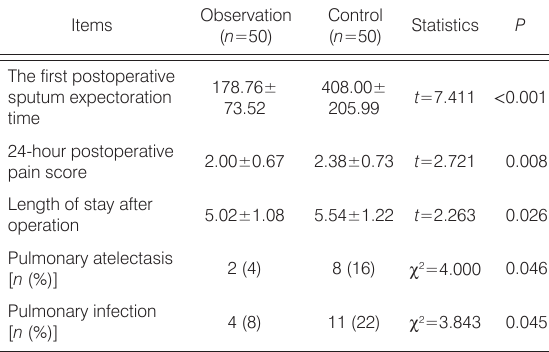
Table 2. Comparison of two groups after the first expectoration time, pain score, and length of hospital